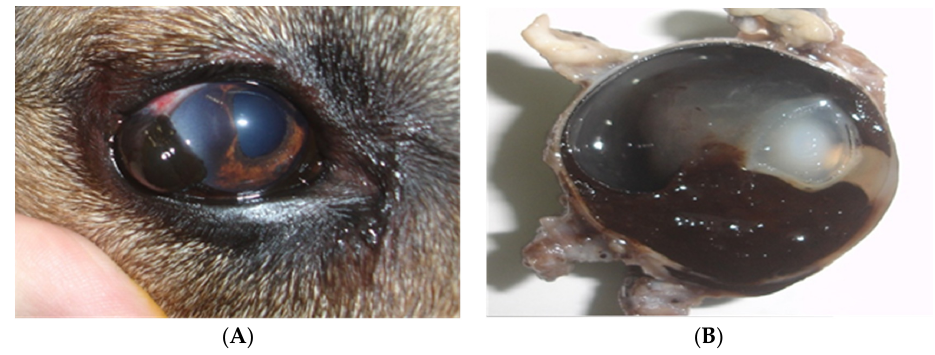
Figure 6. Photographs showing: blackened mass in the iris with extraocular extension ( A ) and sagittal section of the eyeball revealing melanocytic neoplasia of iris, ciliary body, and choroid ( B ) ( Eduardo Perlmann ).